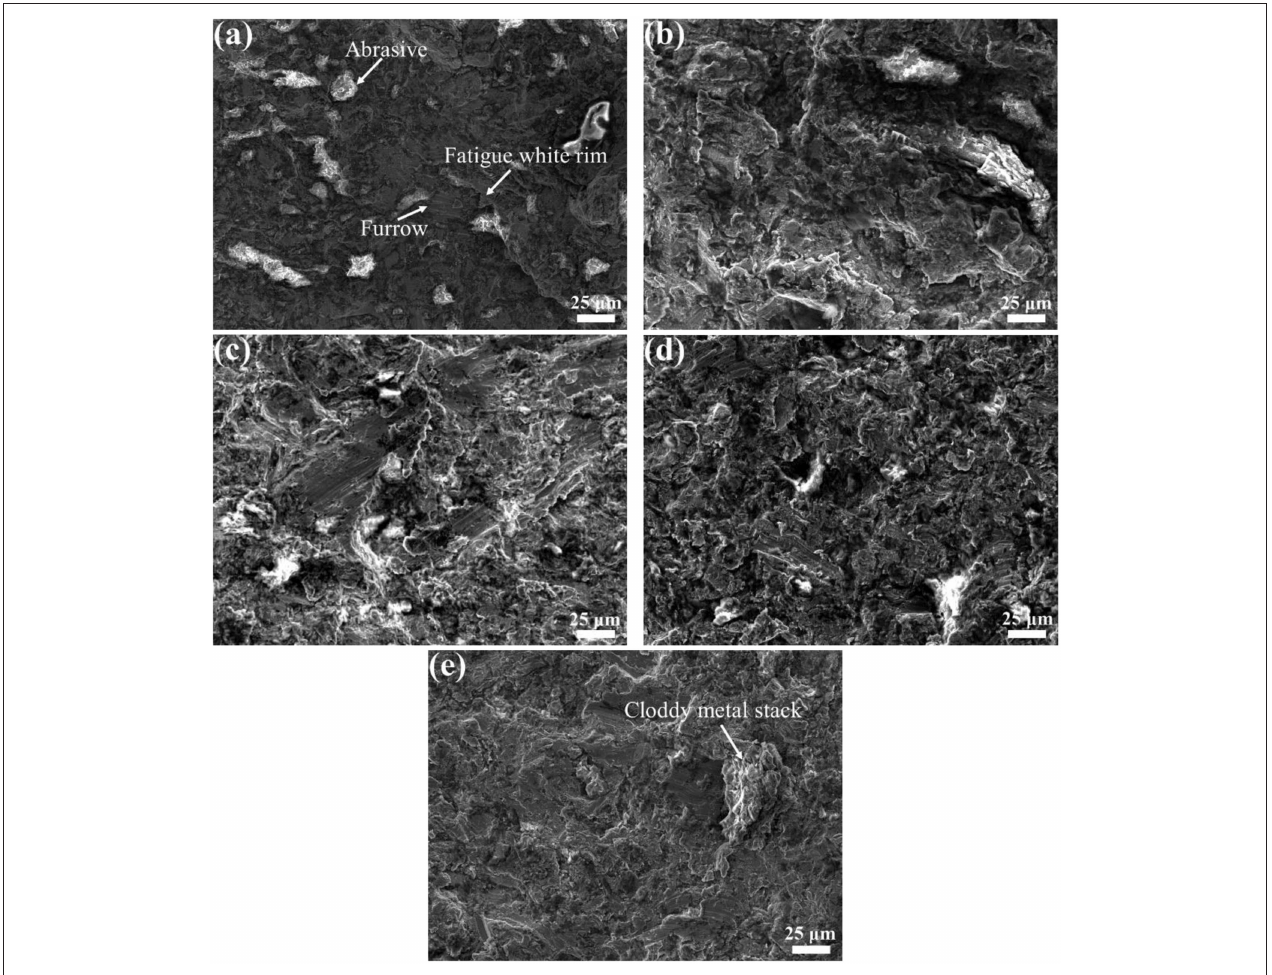
FIGURE 6 | Worn surface of LAWRCS with different carbon content. (a) 0.32 wt.%, (b) 0.35 wt.%, (c) 0.40 wt.%, (d) 0.46 wt.%, (e) 0.55